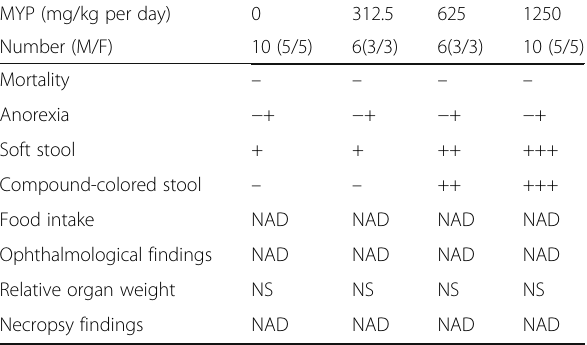
Table 2 Summary of the repeated toxicity test in beagle dogs